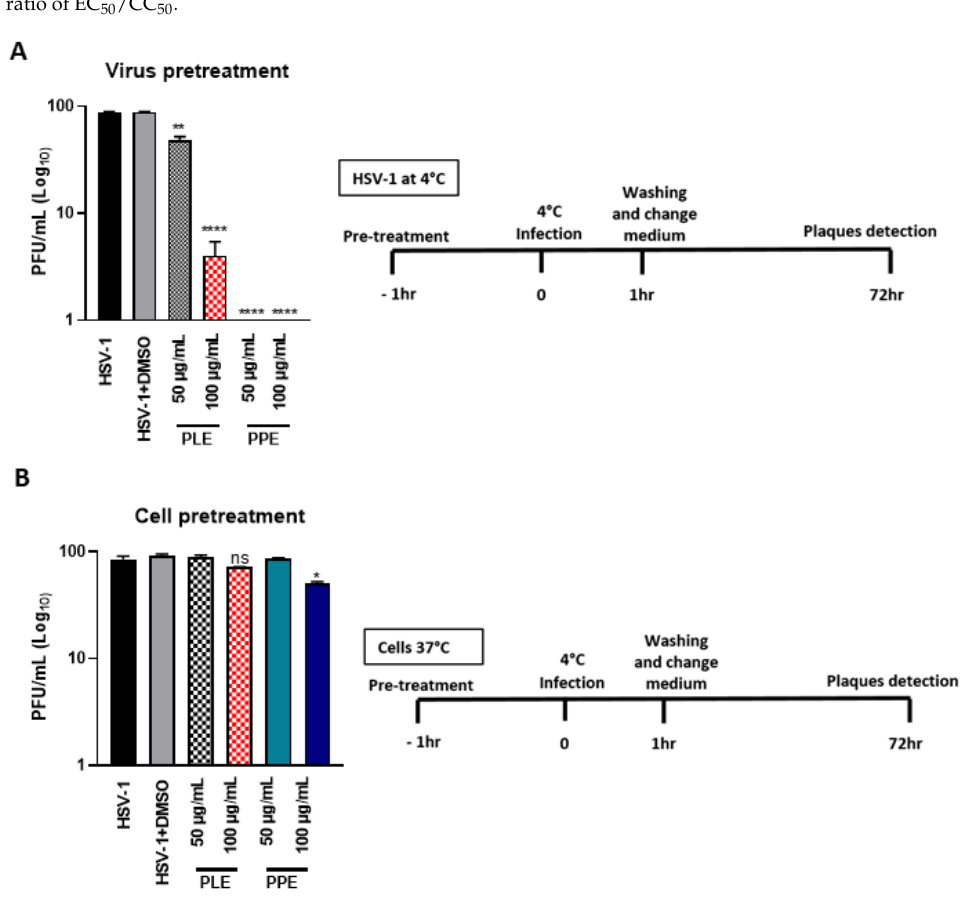
Figure 6. Binding assay following PPE and PLE treatment. Binding experiments were carried out at 4 °C to allow cellular binding but not internalization of the virus and were performed under